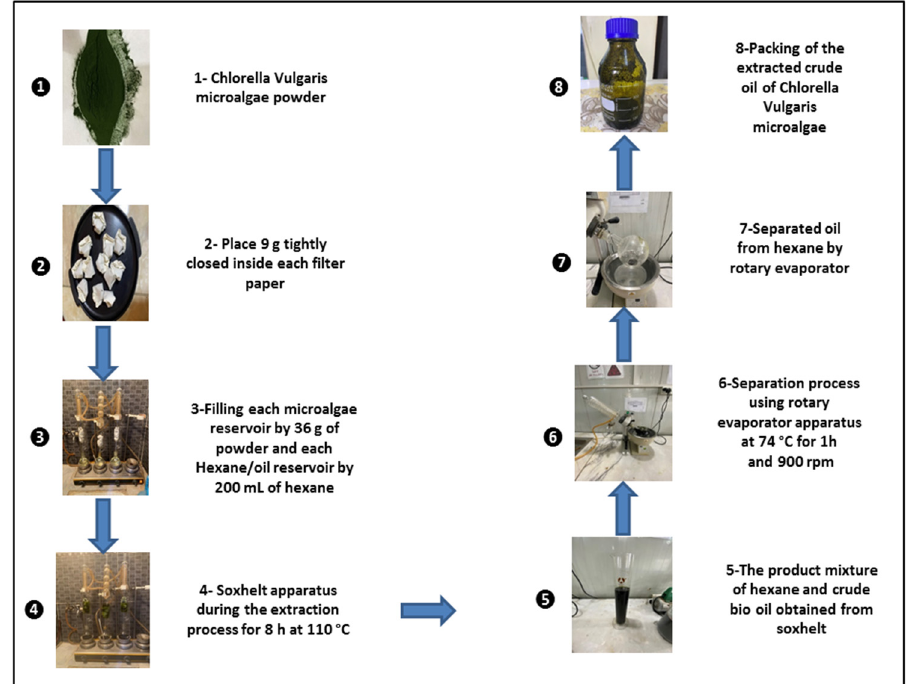
Figure 2. Experimental images for the extraction procedure for the crude oil from Chlorella vulgaris microalgae powder.